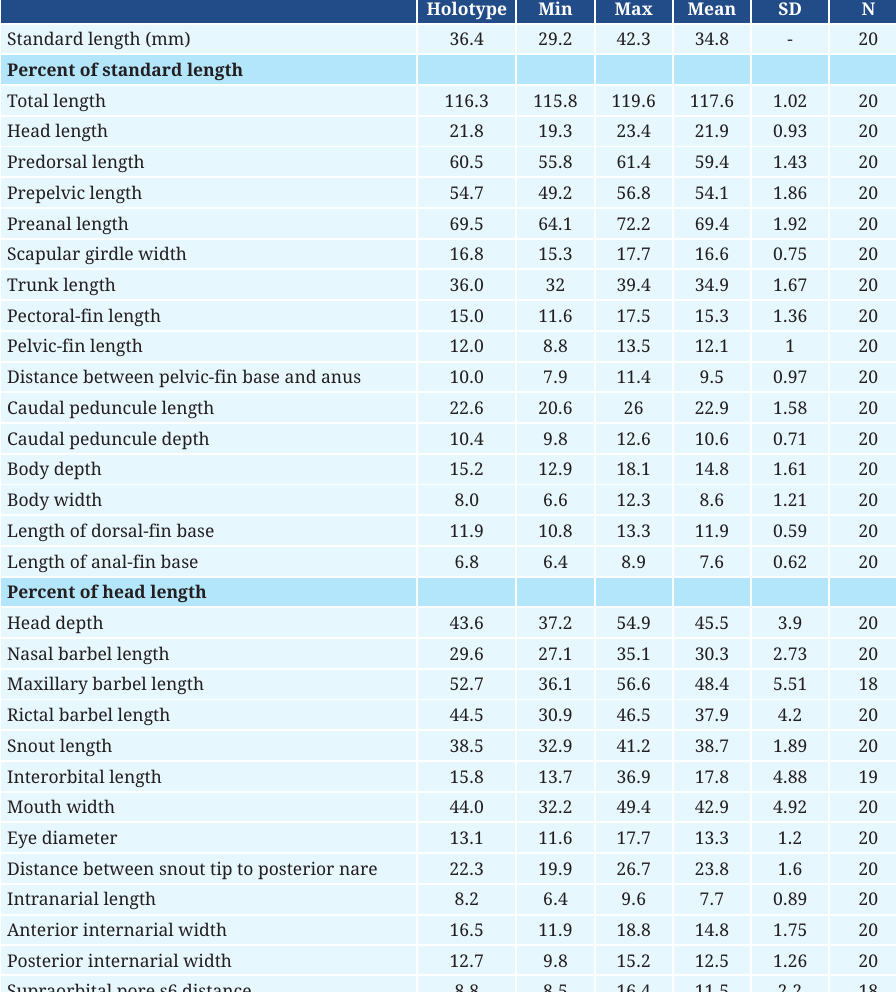
TABLE 2 | Morphometric data of Scleronema guapa , new species (data of holotype included in the range). N = number of specimens; SD = standard